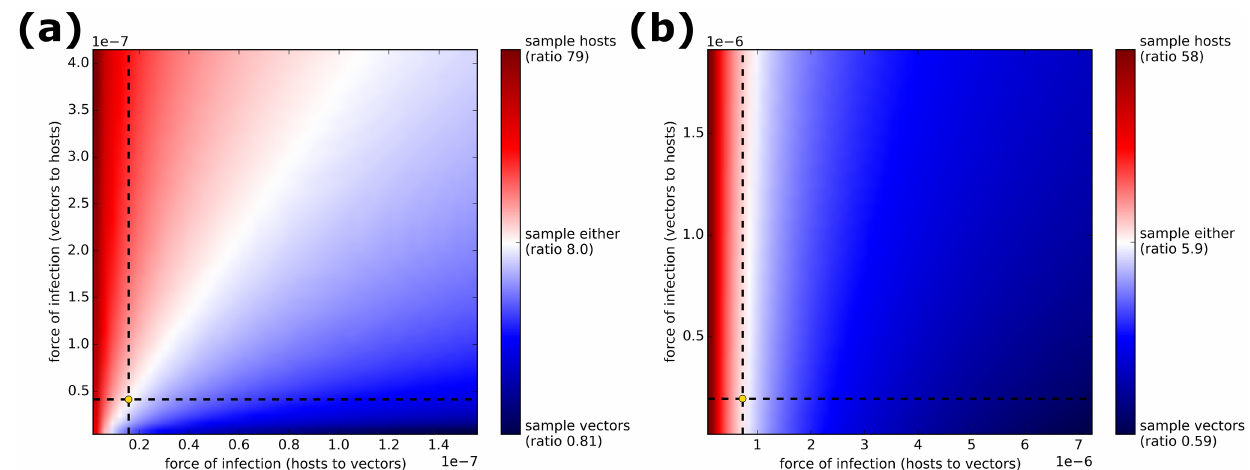
Fig 2. Effect of varying transmission parameters( β ) on the suggested group of sampling for the HLB model (panel (a)) and the tristeza model (panel (b)). We estimate the relative samplingefforts requiredfrom vectors comparedto that from hosts when using the current model parameters (located at the intersection of the dashed lines) using the ratio comparedto vectors is equal to this threshold (8 for HLB, 6 for Tristeza)—indicating the ‘equivalence point’ as describedin the text. The numbers in the key on the right describethe relative vector samplingeffort to the ratio of the relative vector samplingeffort to the relative host samplingcost z h discriminate values less than 1. Regionsshown in red have a samplingeffort ratio greater than the cost ratio (suggesting that samplinghosts wouldminimisethe total cost) and those in blue have a ratio less than the cost ratio (suggesting that samplingvectors would minimisethe total cost). The frontier betweenthese two (indicatinga ratio equal to the cost ratio) is shown in white.